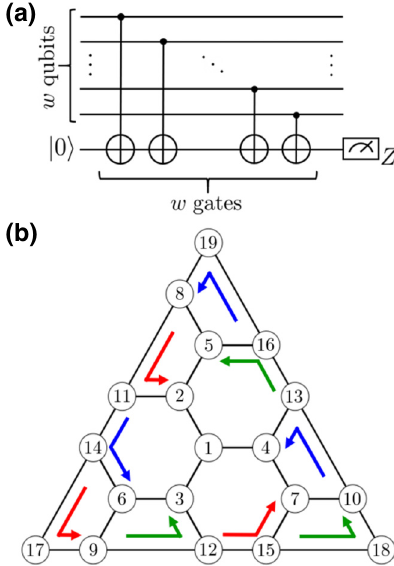
FIG. 12. (a) A nonflag circuit for measuring a generator of the capped color code of distance 5 in H form, where w is the weight of the generator. (b) The orderings of data CNOT gates that give a distinguishable fault set F 2